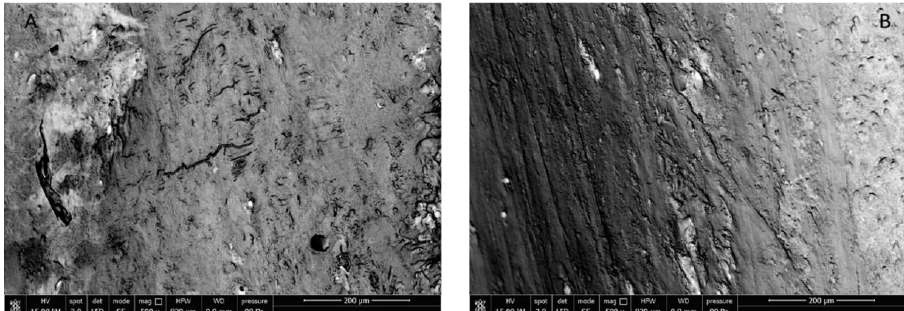
Figure 6. SEM images of external surface of sham ( A ) and ova ( B ) rat femur.